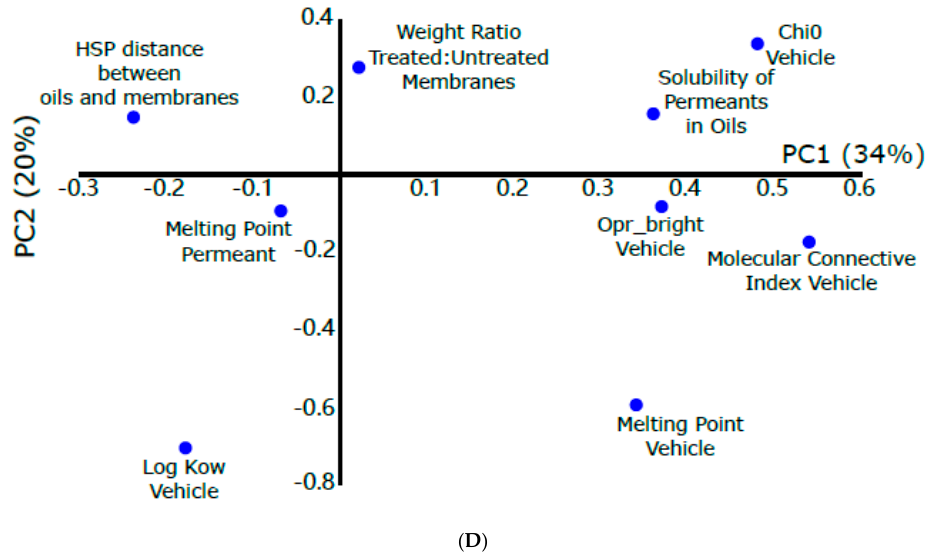
Figure 3. ( A ) Scores plot from the PCA of flux and ( C ) scores plot from the PCA of permeation coefficient through synthetic membranes showing clear groupings with respect to the different vehicles used (IHD in red, HD in orange, OA in green and IPM in blue). ( B ) Loading plots from the PCA of flux and ( D ) loading plots from the PCA of permeation coefficient across synthetic membranes showing high loadings for descriptors primarily related to the physicochemical properties of the vehicle and the solubility of the permeants in the vehicle contributing most to explaining the variance observed in the datasets.